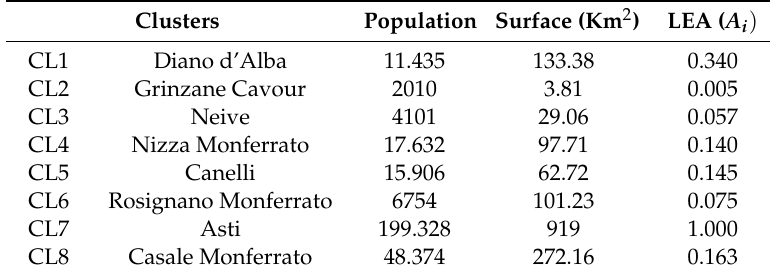
Table 5. Parameters of the dynamic model for the LRM landscape (core and bu ff er